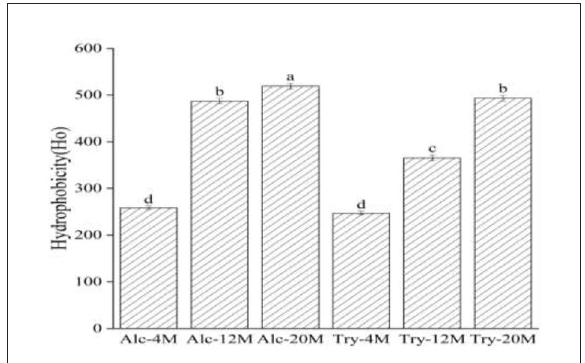
FIGURE4 Surface hydrophobicity of macroporous adsorption resin extracts. The values in a column followed by different letters were significantly different ( p < 0.05).